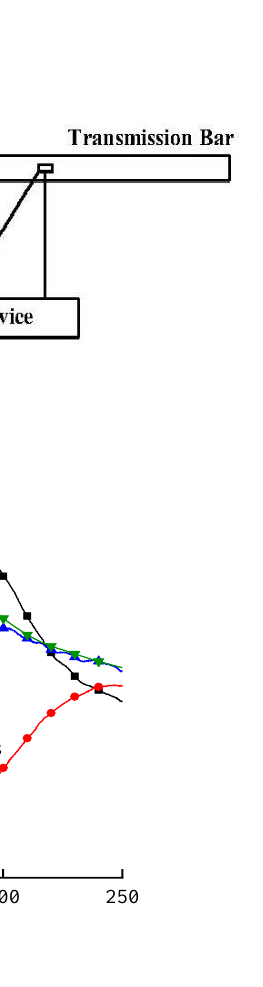
Figure 3. Stress balance curve.